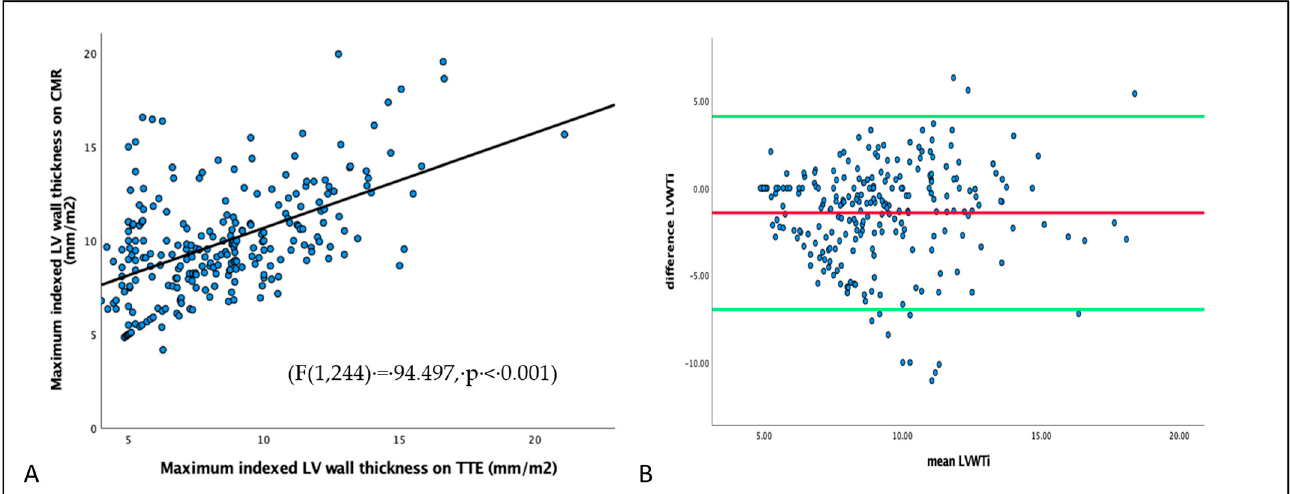
analysis due to collinearity with LV LGE and LV MI .